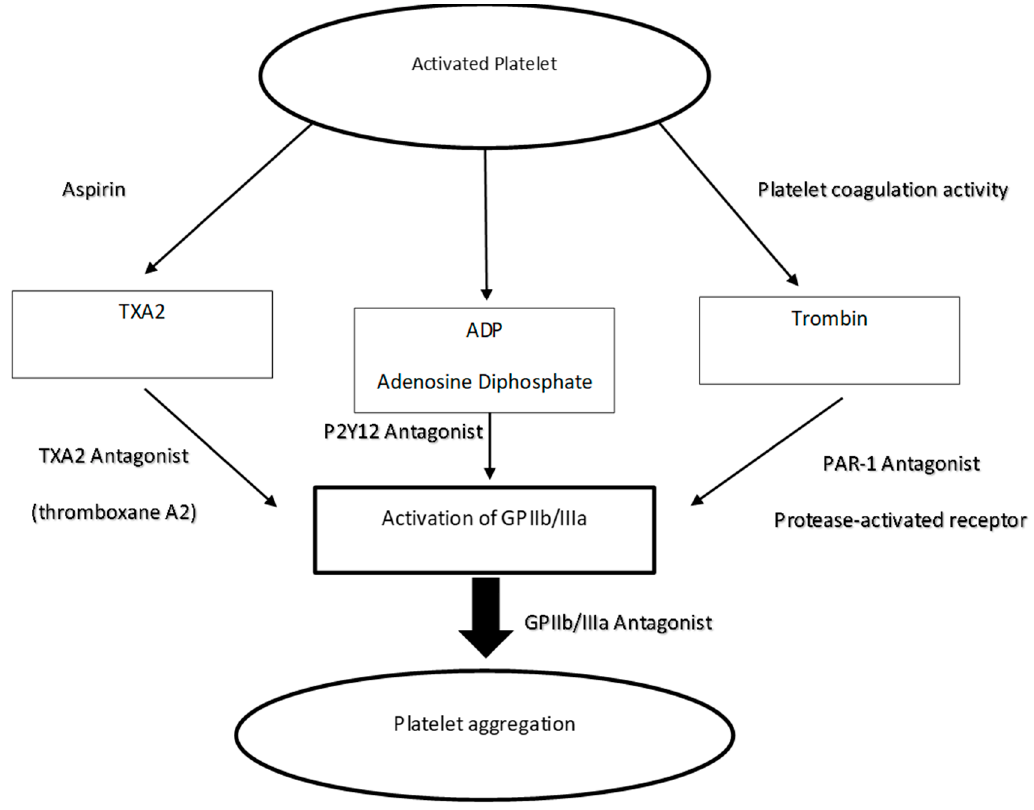
Figure 2. In the diagram the three ways that can inhibit platelet aggregation are evident. Antiplatelet drugs can act through three mechanisms: Interaction with platelet receptors for substances produced on the outside of platelets, such as collagen, thrombin, some prostacyclines and catecholamines. Interaction with platelet receptors for substances produced within platelets such as ADP, serotonin and prostaglandins D2 and E2. Interaction with platelet receptors for substances produced in platelets such as thromboxane A2, cAMP, cGMP and calcium ions. [1]. Among the anti-platelet agents of the thromboxane A2 (TXA2) receptor and of the synthesis of the same we find the picotamide. It is an orally-administered active substance that is able to carry